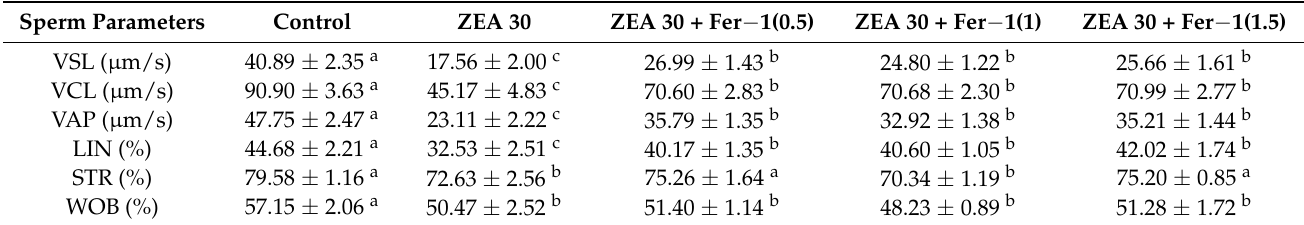
Table 2. Parameters of sperm motility.